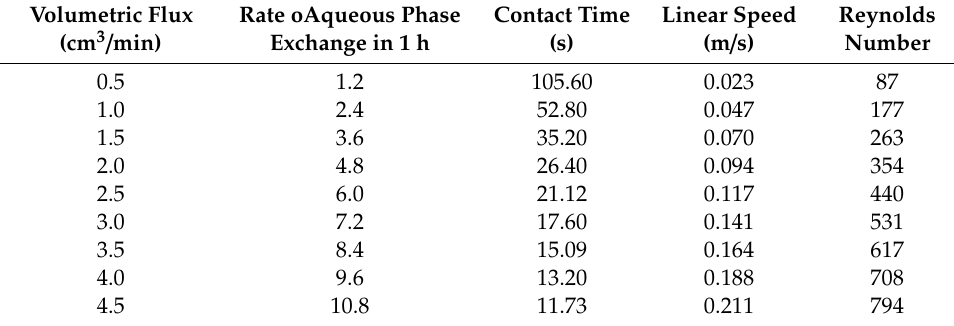
Table 4. Hydrodynamic properties of spiral module.